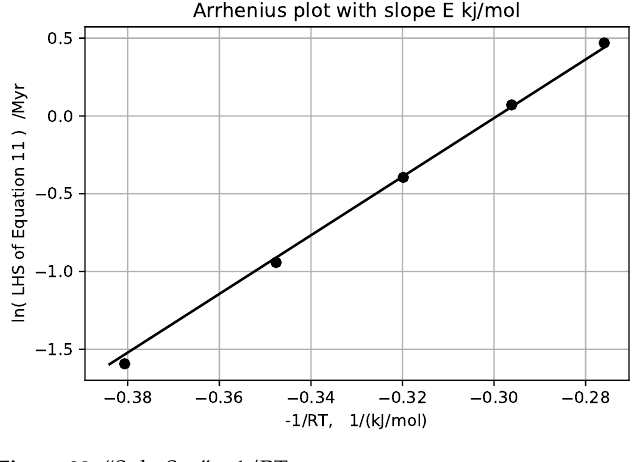
Figure 22. “Sulu Sea” − 1/RT.